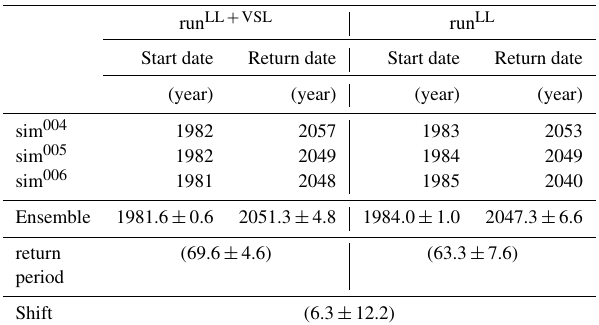
Table 2. Estimation of the ozone return date based on the period of time where the annual minimum (cid:49) TOZ SP spring for different simulations and ensemble